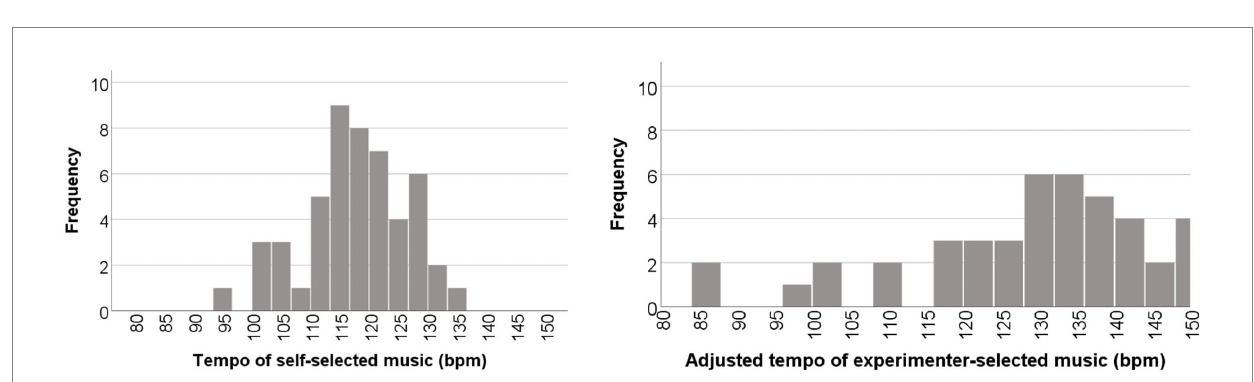
FIGURE 4 Distributions of preferred musical tempos (left: self-selected music; right: experimenter-selected music).